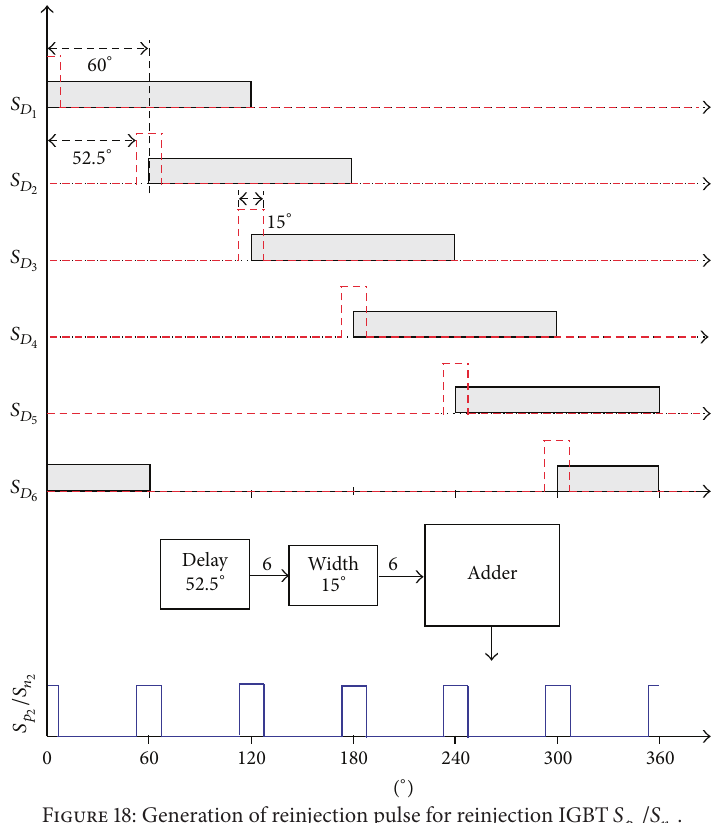
Figure 18: Generation of reinjection pulse for reinjection IGBT 𝑆 𝑝